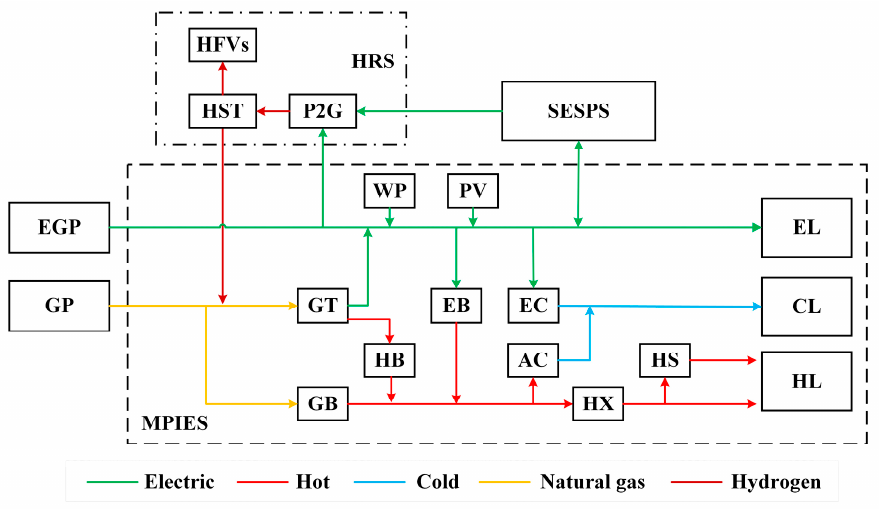
Figure 1. The structure of MPIES, SESPS, and HRS.